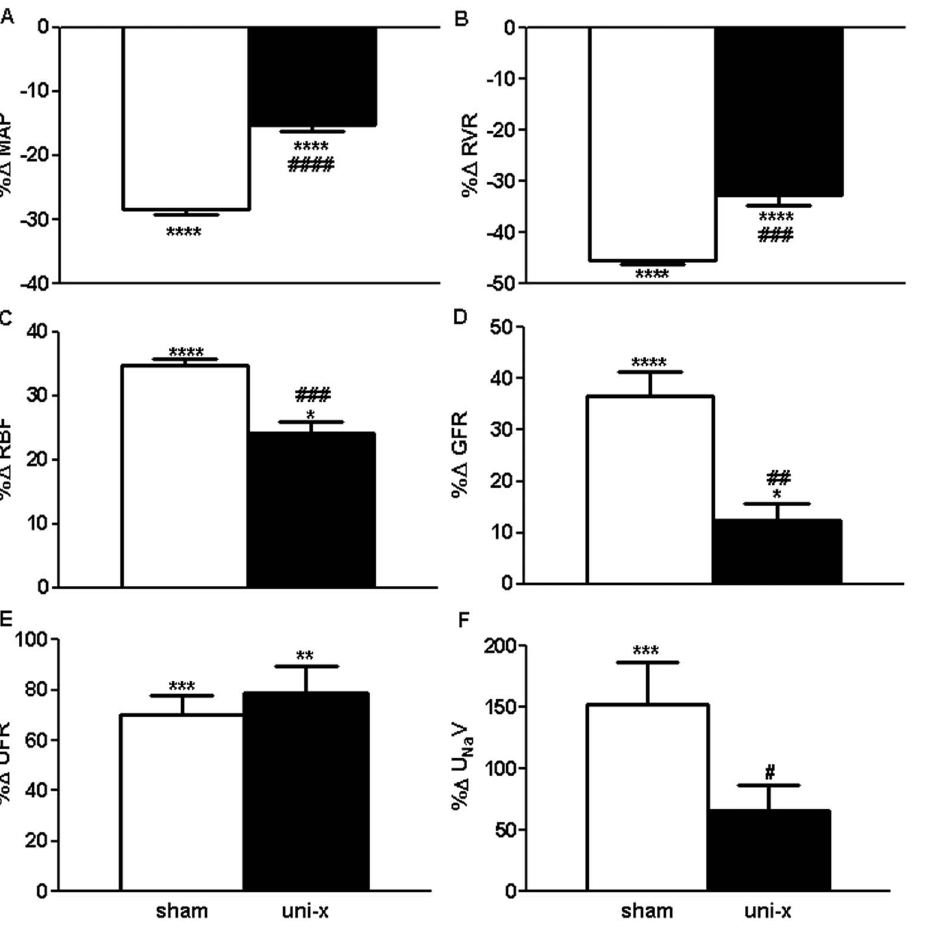
Figure 2. Cardiovascular and renal responses to AT1R blockade via intravenous infusion of losartan expressed as percentage change (% D ) from basal period 2 in sham and uni-x female sheep at 5 years of age (n=5/group). MAP, mean arterial pressure; RVR, renal vascular resistance; RBF, renal blood flow; GFR, glomerular filtration rate; UFR, urine flow rate; U Na V, urinary sodium excretion; all values except MAP are corrected for total kidney weight (gkw).B2, basal period 2; sham: white bars, uni-x: black bars, *P , 0.05, **P , 0.01, ***P , 0.001, ****P , 0.0001 from Bonferroni post-hoc test comparing responses of sham or uni-x animals to losartan from their basal period 2. # P , 0.05, ## P , 0.01, ### P , 0.001, #### P , 0.0001 from student’s t-test comparing sham and uni-x.Values are mean 6 SEM.